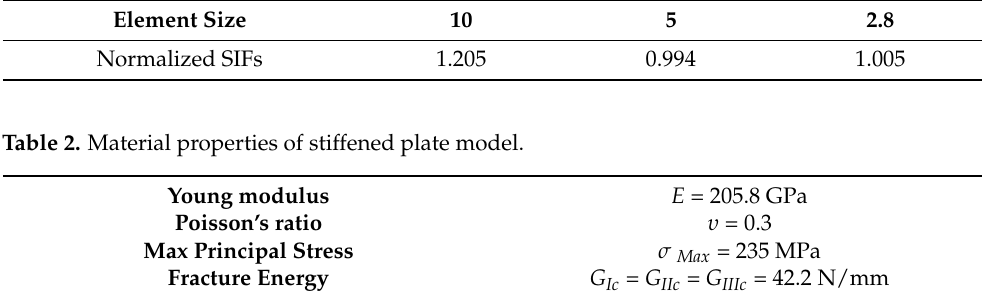
Table 2. Material properties of stiffened plate model.